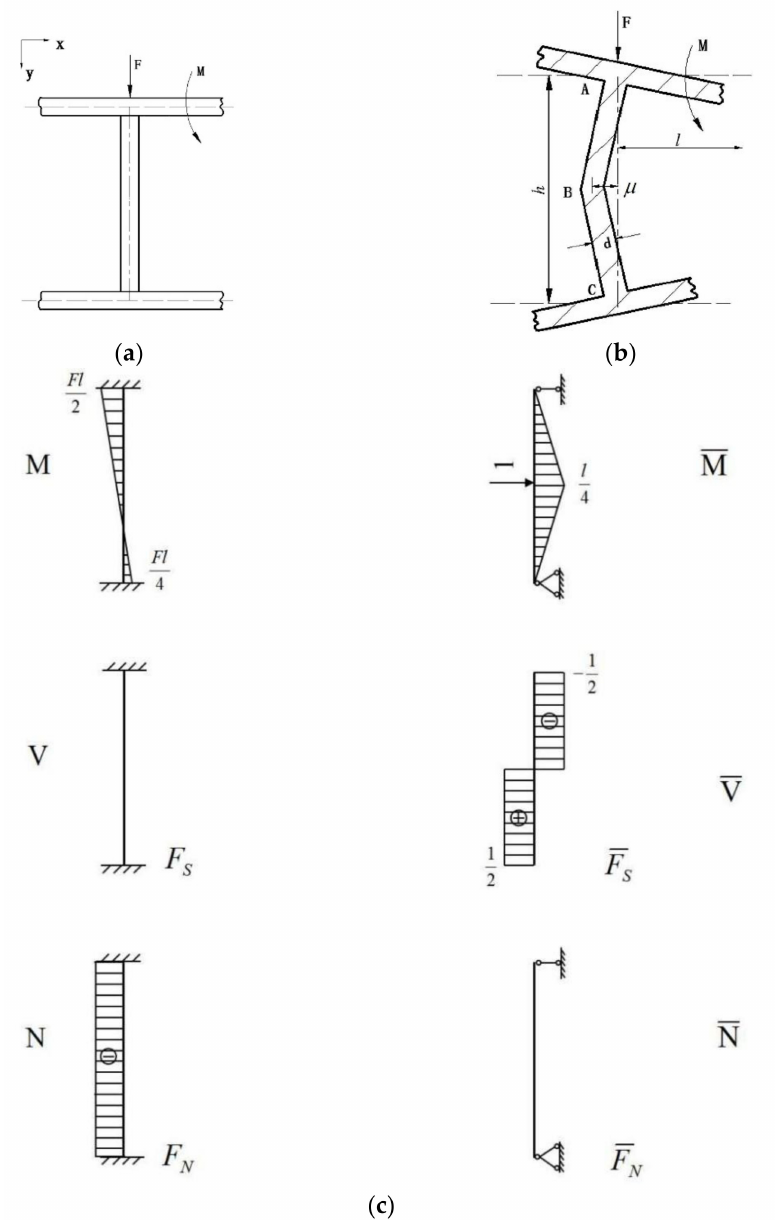
Figure 12. Force analysis of supporting plate of interlocking grid structure. ( a ) Force diagram; ( b ) force deformation diagram; ( c ) force decomposition